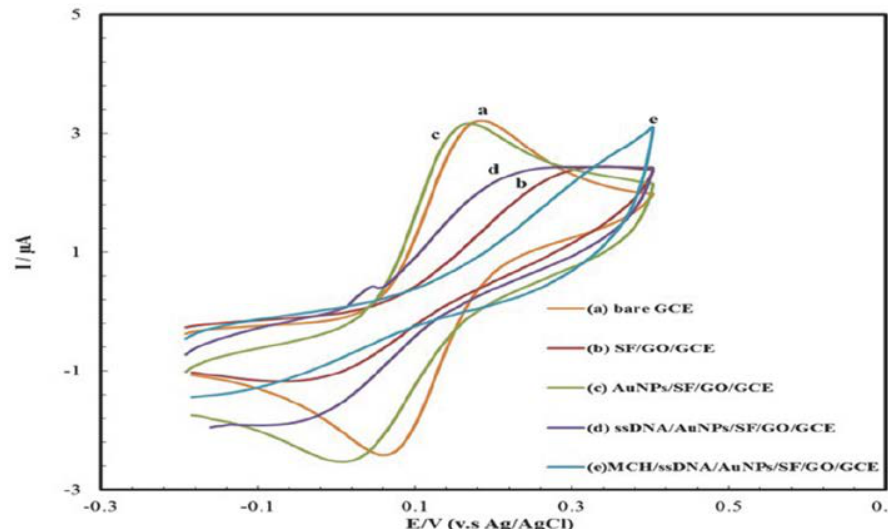
Figure 3. Cyclic voltammograms obtained for a 1.0 mmol L –1 [Fe(CN) 6 ] 3–/4– and 0.1 mol L –1 KCl solution at the surfaces of (a) bare GCE, (b) SF/ GO/GCE, (c) AuNPs/SF/GO/GCE, (d) ssDNA/ AuNPs/SF/GO/GCE, (e) MCH/ssDNA/AuNPs/SF/GO/GCE (CV condition: scan rate 50 mV s –1 ).